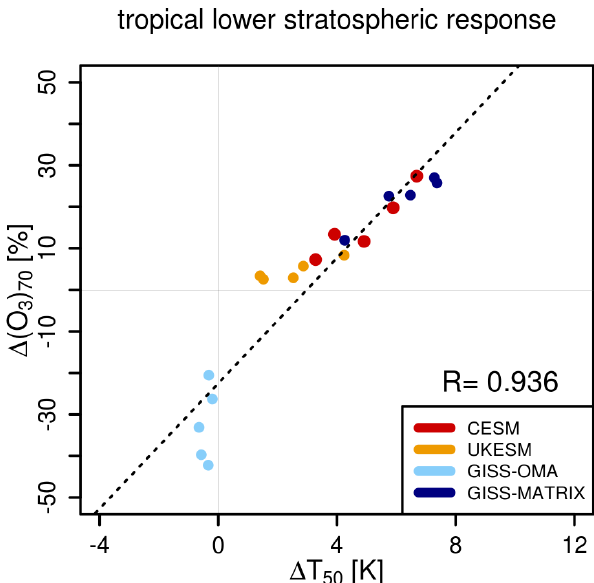
Figure 8. Correlation between yearly mean 30 ◦ S–30 ◦ N changes in temperature at 50hPa and ozone at 70hPa between each of the SAI experiments and SSP2–4.5. Colors indicate the models, and the dashed black line shows a linear fit to all results for the four models